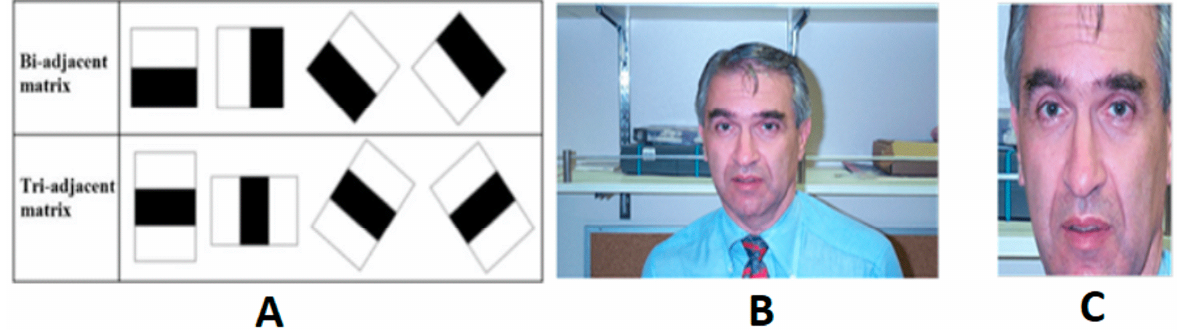
Figure 5. An example of face detection with rotated Haar-like rectangular features: ( A ) 45°-rotatable rectangle features, ( B ) original image with a face, and ( C ) face detection result.